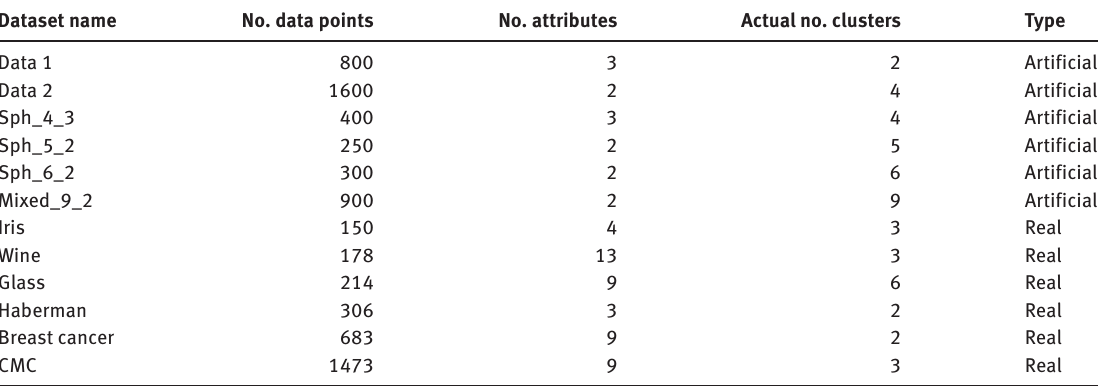
Table 1: Characteristics of the datasets